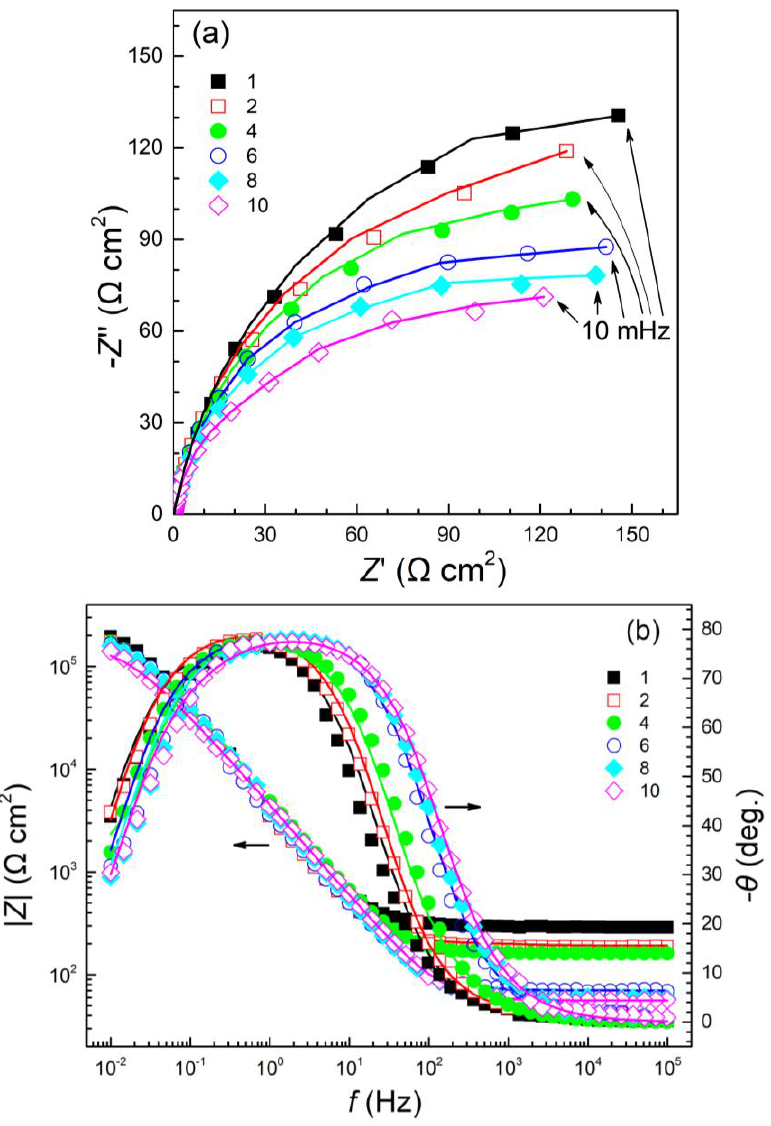
Figure 2. Impedance spectra ( a ) Nyquist and ( b ) Bode for specimens in the synthetic tap water solutions with different concentration ratios from 1 to 10 times. Symbols: experimental data; lines: fitted values.